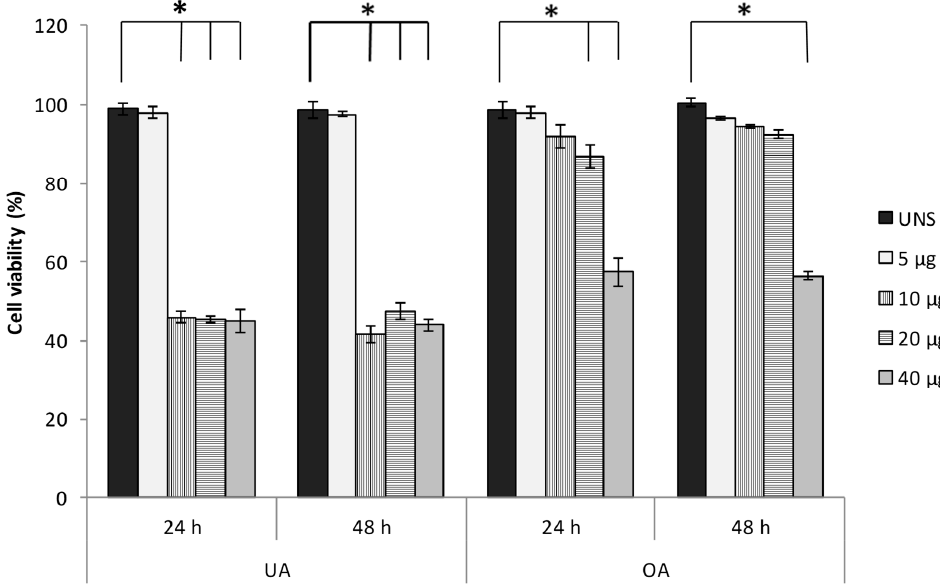
Figure 1. The effect of ursolic and oleanolic acids on A549 human lung cancer cells viability. A549 cell monolayers were stimulated with several concentrations of ursolic acid (UA) or oleanolic acid (OA) (5, 10, 20, and 40 µg/mL) and trypan blue assay was performed. The results are presented as the